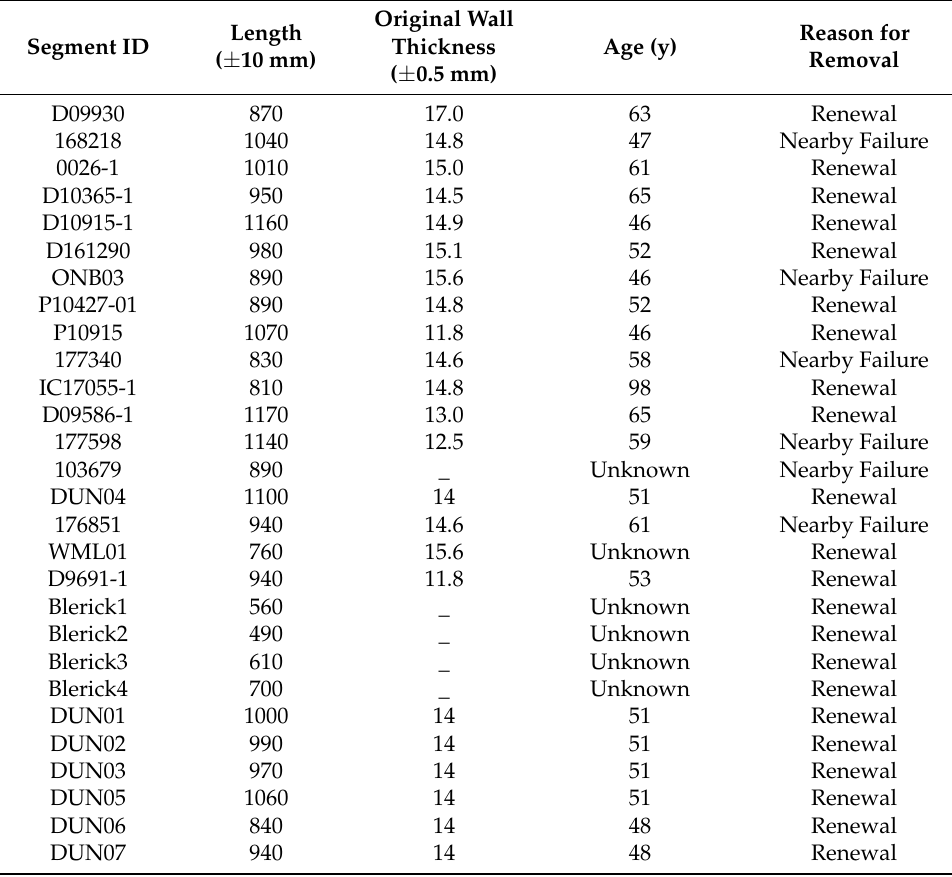
Table 1. Properties of the field